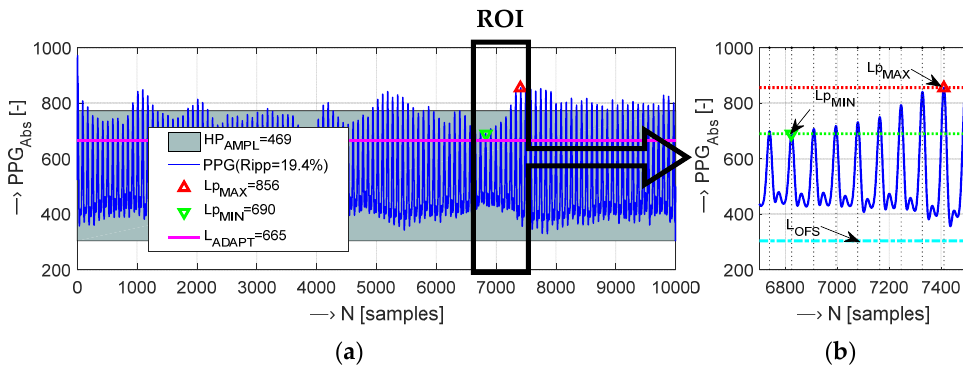
Figure 3. Visualization of adaptive signal level threshold determination: ( a ) whole 10-k sample PPG signal with determined Lp MAX , Lp MIN levels, HP AMPL and heart ripple parameters, and finally calculated L ADAPT level , ( b ) ROI within 80th–89th PPG cycles with localized systolic peaks, determined Lp MAX / Lp MIN values, and global L OFS value; f s = 100 Hz.